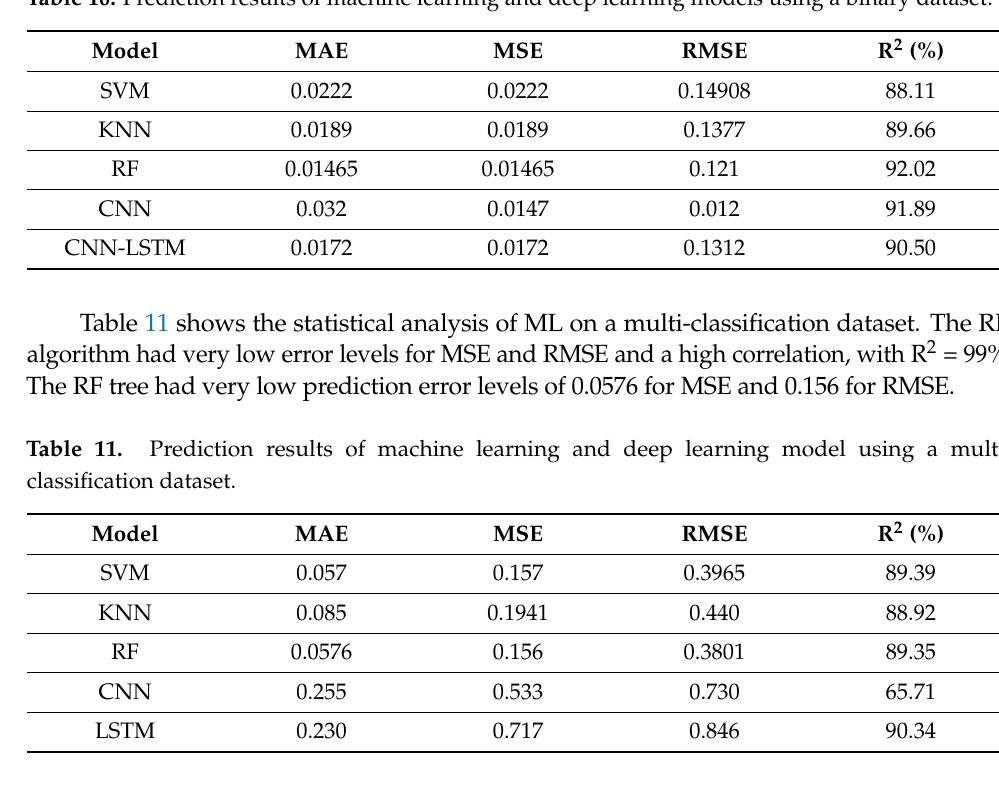
Table 10. Prediction results of machine learning and deep learning models using a binary dataset.